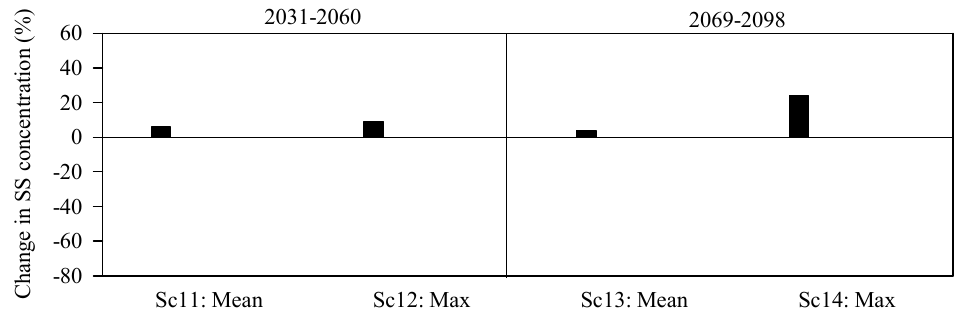
Figure 8. Response of suspended sediment concentration to combined changes in temperature, rainfall and CO 2 concentration based on the scenarios defined in Table 1. Sc11: T + mean 2031–2060 °C, P–mean 2031%–2060%, CO 2 550; Sc12: T + max 2031–2060 °C, P–mean 2031%–2060%, CO 2 550; Sc13: T + mean 2069–2098 °C, P–mean 2069%–2098%, CO 2 660; Sc14: T + max 2069–2098 °C, P–max 2069%–2098%, CO 2 660.